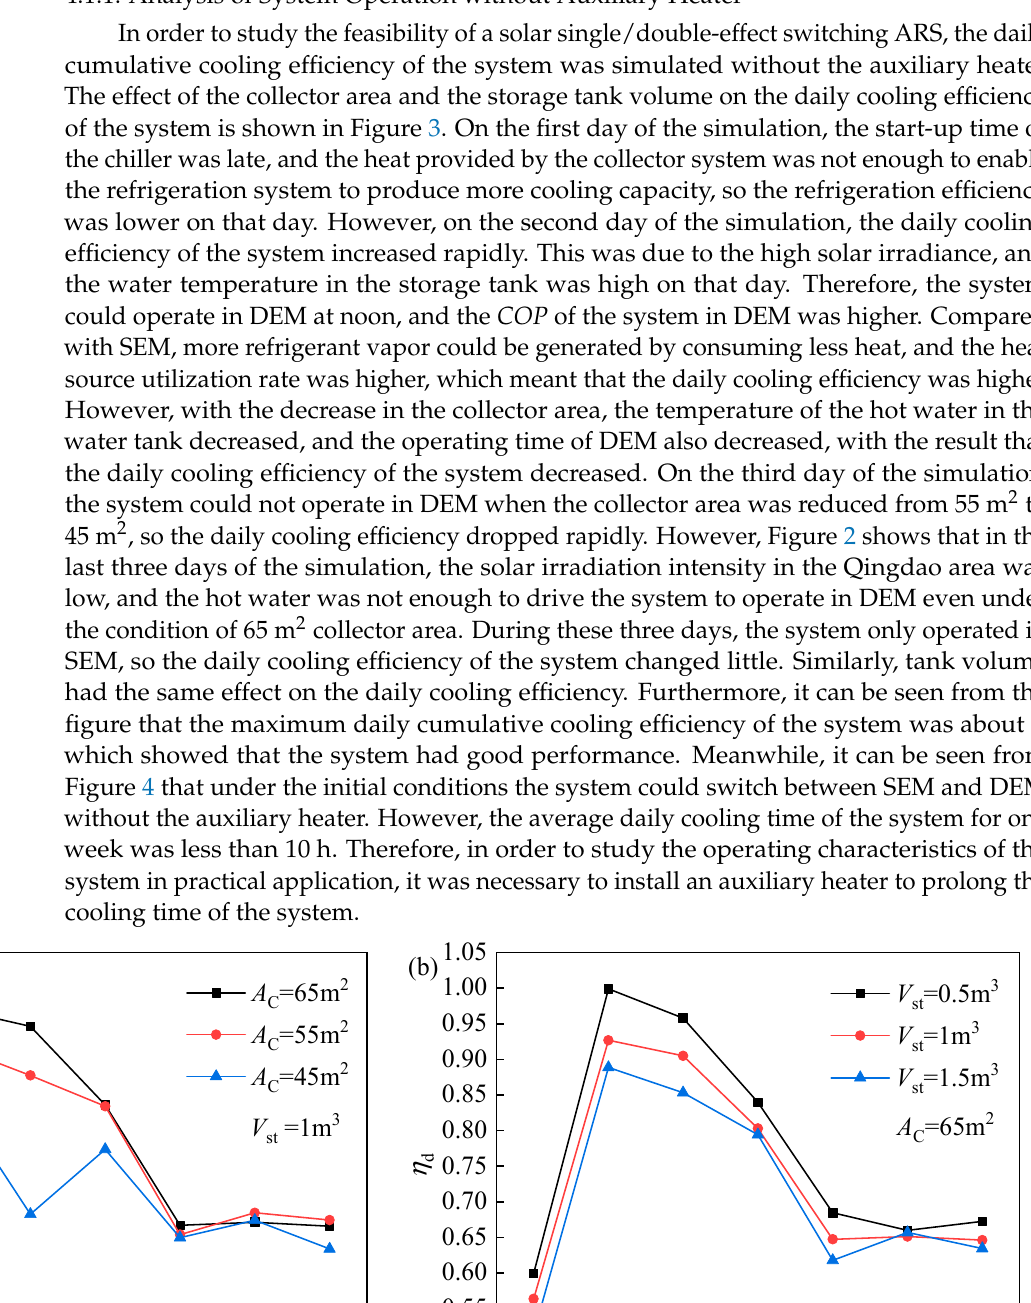
Figure 4. Daily single- and double-effect operation mode switching and daily cumulative cooling capacity of the system without auxiliary heater. 4.1.2. Analysis of System Operation with Auxiliary Heater In order to study the actual operation characteristics of the solar single/double-effect LiBr-H 2 O ARS and facilitate experimental verification in the future, a laboratory scale sys- tem with a daily cooling time of 7:00–19:00 was proposed. The design parameters of the system are shown in Table 2 and the operating parameters are shown in Table 3. Table 2. Values for design parameters of the system. Parameter